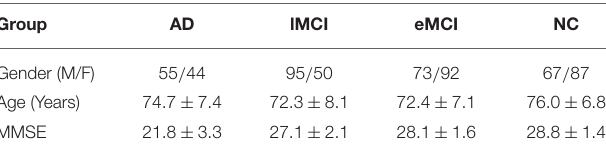
TABLE 1 | Demographic information of all rs-fMRI scans of the subjects used in this study (Mean ± SD). Group AD lMCI